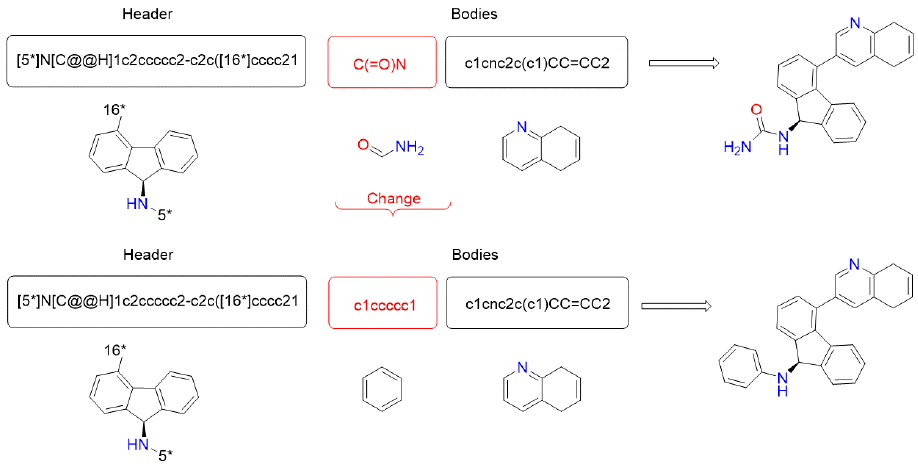
Figure 5. Change movement example.